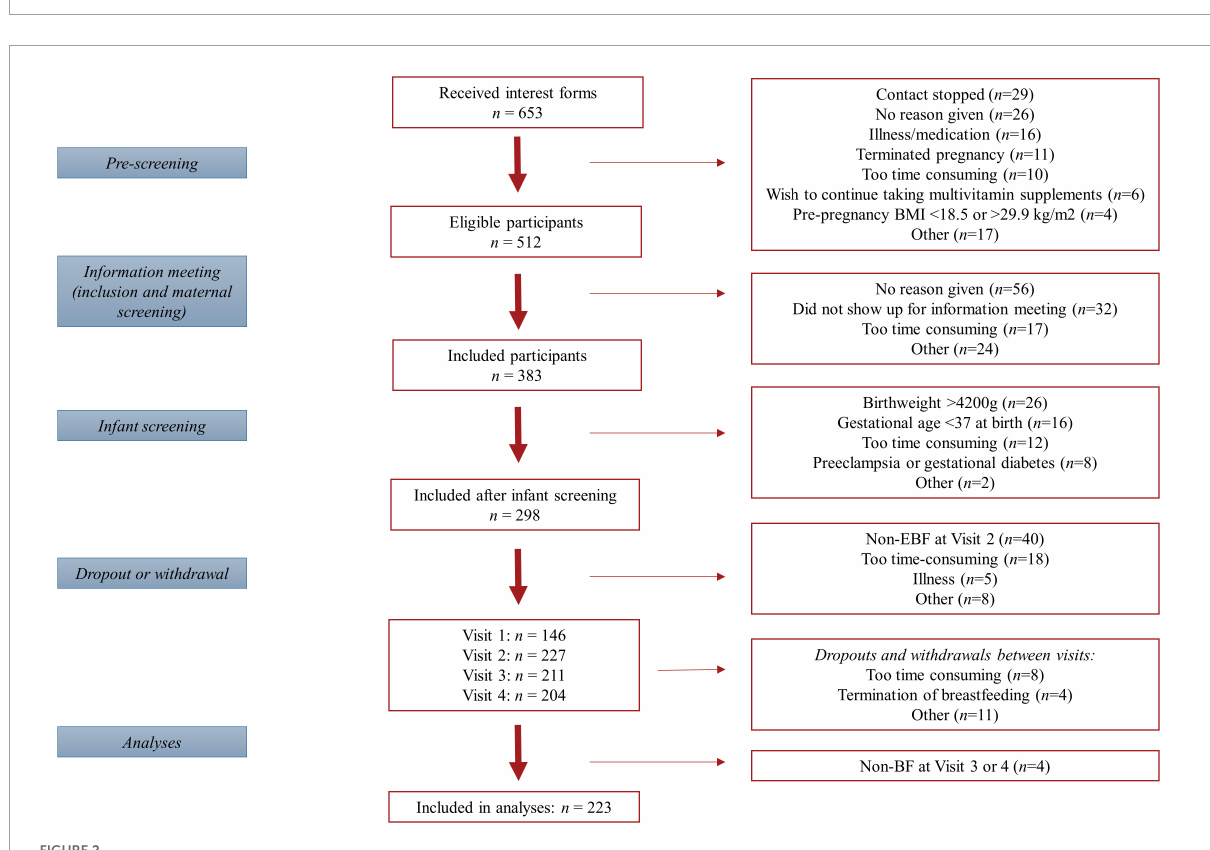
differ significantly from the completers with regards to relevant outcomes and/or baseline data (data not